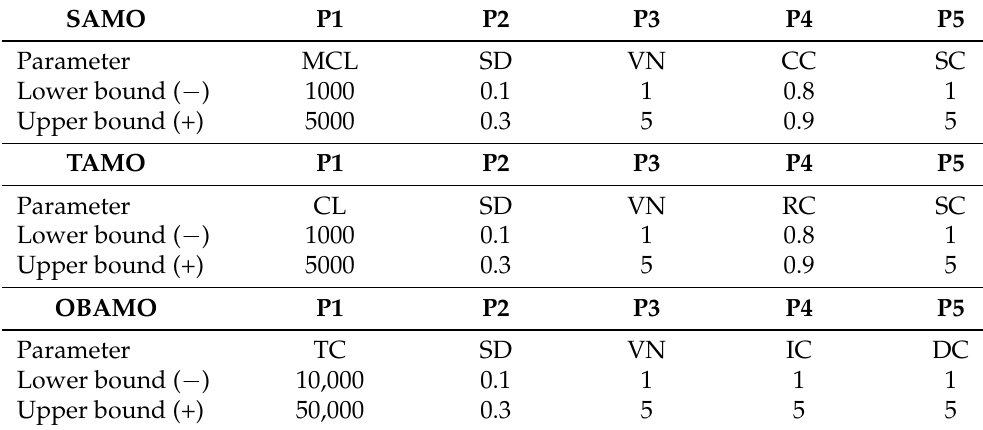
Table 4. Metaheuristic parameter bounds considered in the